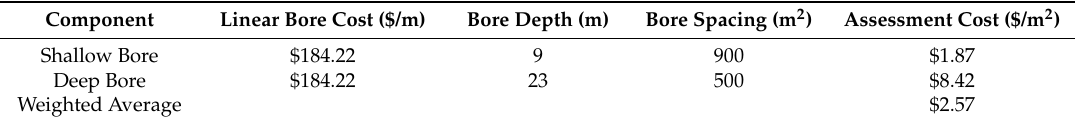
Table 6. Cost of geotechnical assessment components (2012 US dollars)